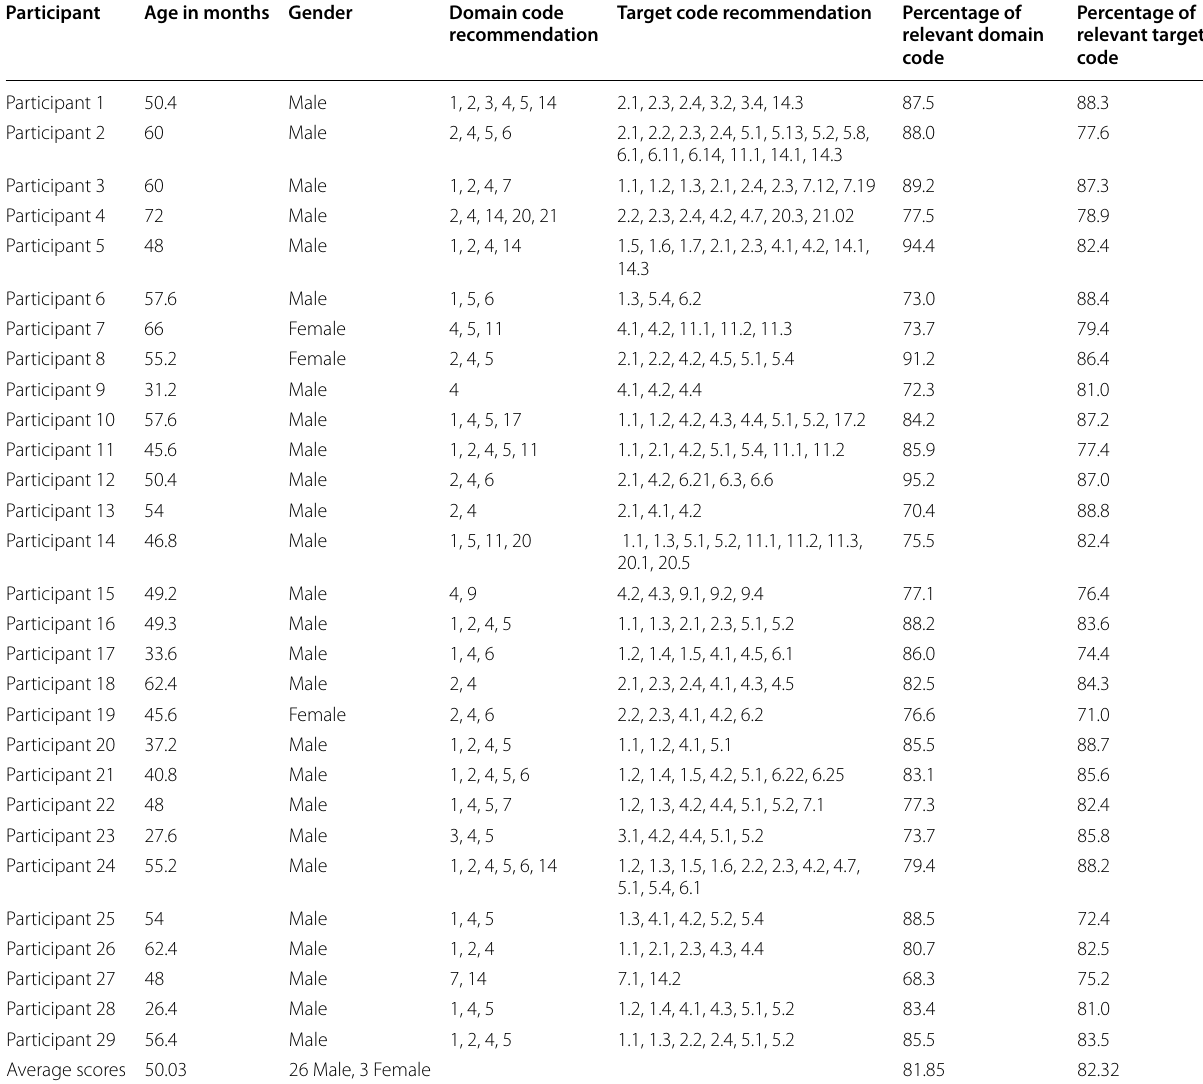
Table 8 Results of domain and target recommendation of all participants using collaborative filtering model on commonality measure Participant Age in months